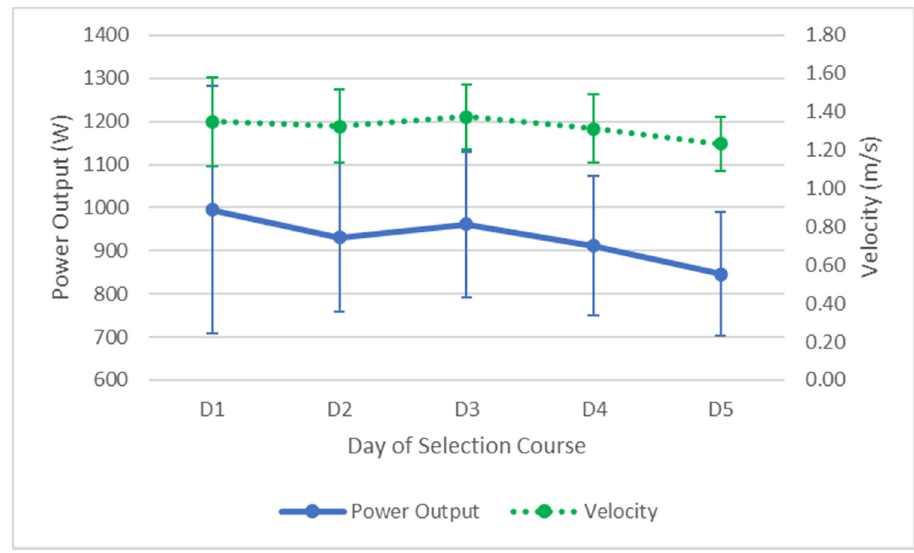
Figure 7. Average changes (±SD) in bench pull performance over the five days. Solid line represents power output, dotted line represents velocity.